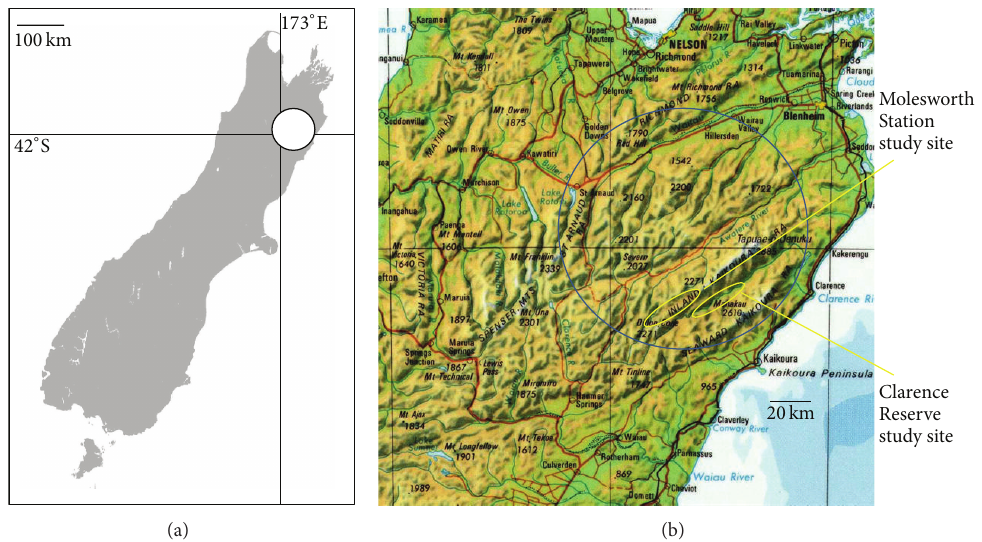
Figure 1: Outline map of the South Island of New Zealand highlighting the northern South Island high country region (circled), within which the Molesworth Station and Clarence Reserve study sites are